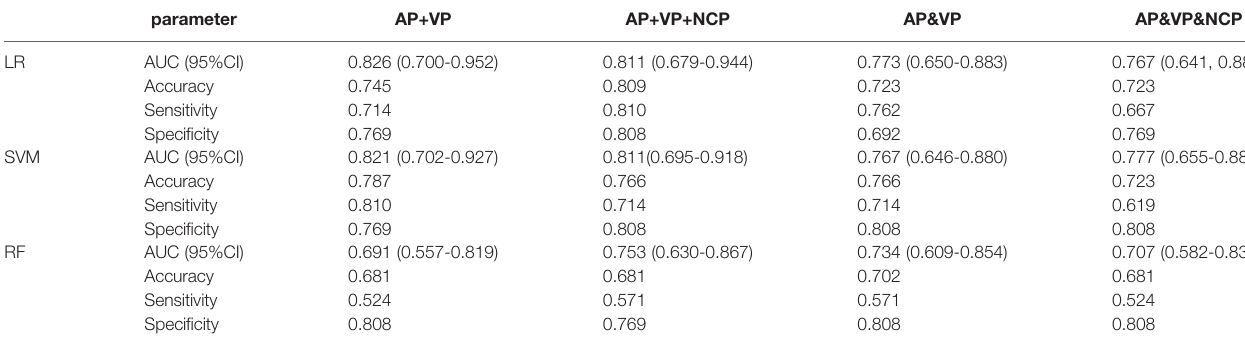
TABLE 4 | Performance of the combine phase model in the test